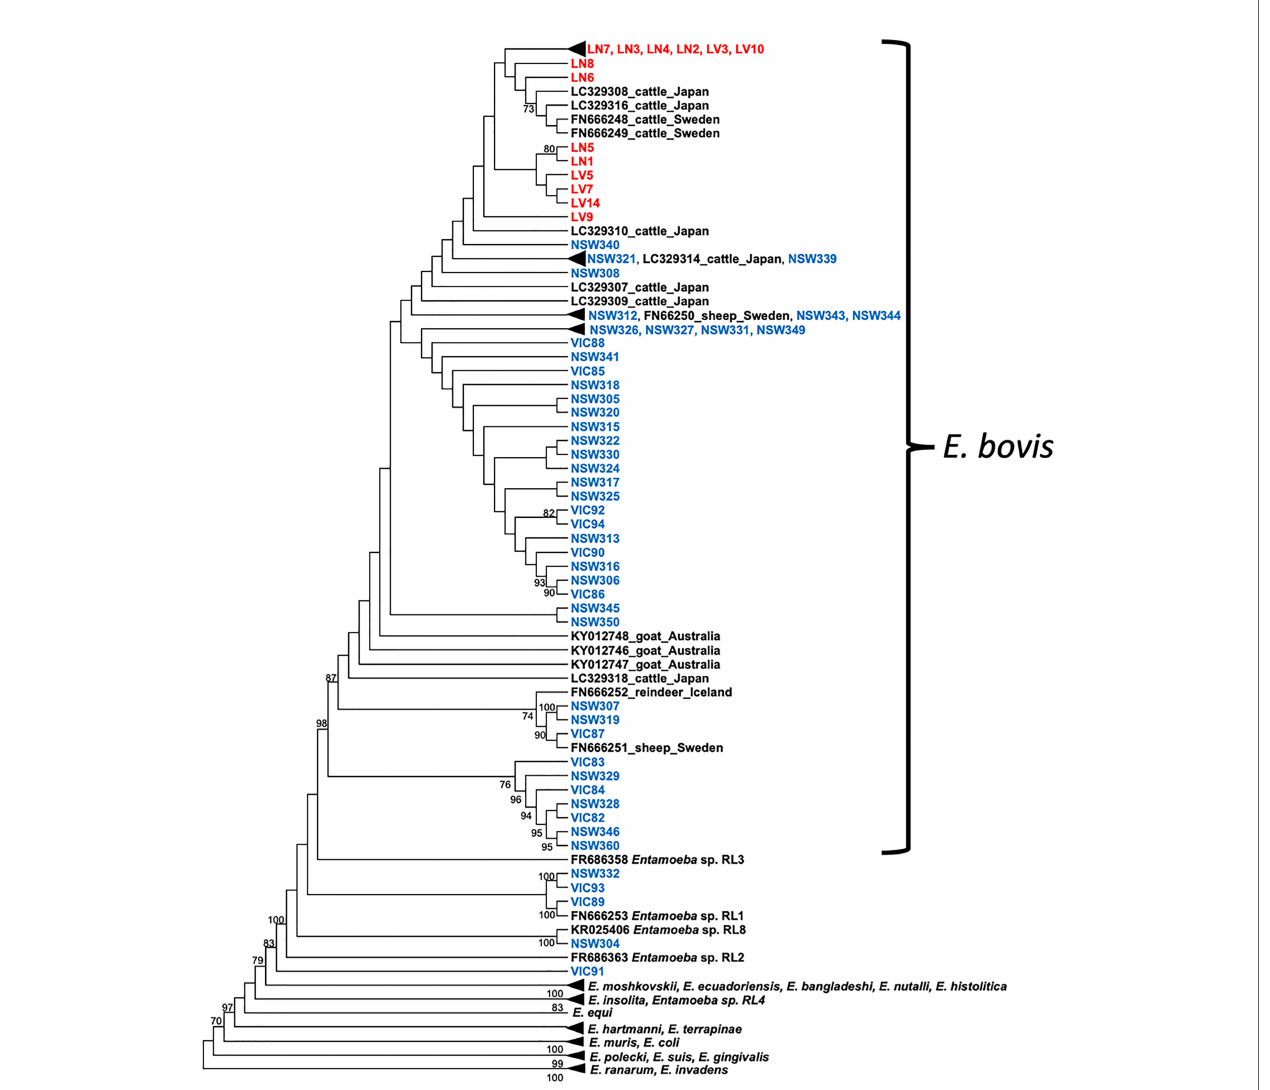
FIGURE 2 | Cladogram of Entamoeba partial 18S rRNA sequences. Deer sequences are indicated in blue and cattle sequences in red. Reference sequences are indicated in black. The tree was constructed using the maximum likelihood method and Tamura 3-parameter + G substitution model. Bootstrap values above 70% are shown at the nodes. Note: substitutions do not scale branches in this tree. The phylogenetic tree with scaled branches and alignment is shown in Figures S2 , S3 ,